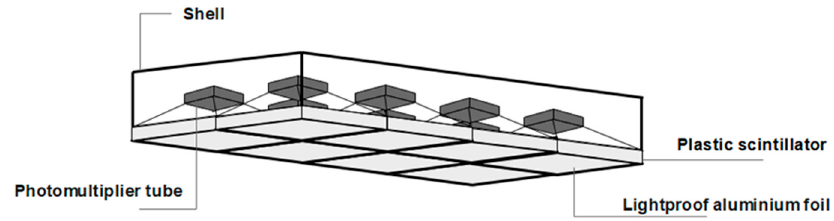
Figure 2. Surface-contamination monitor’s construction diagram. Table 2. Main parameters of the surface-contamination